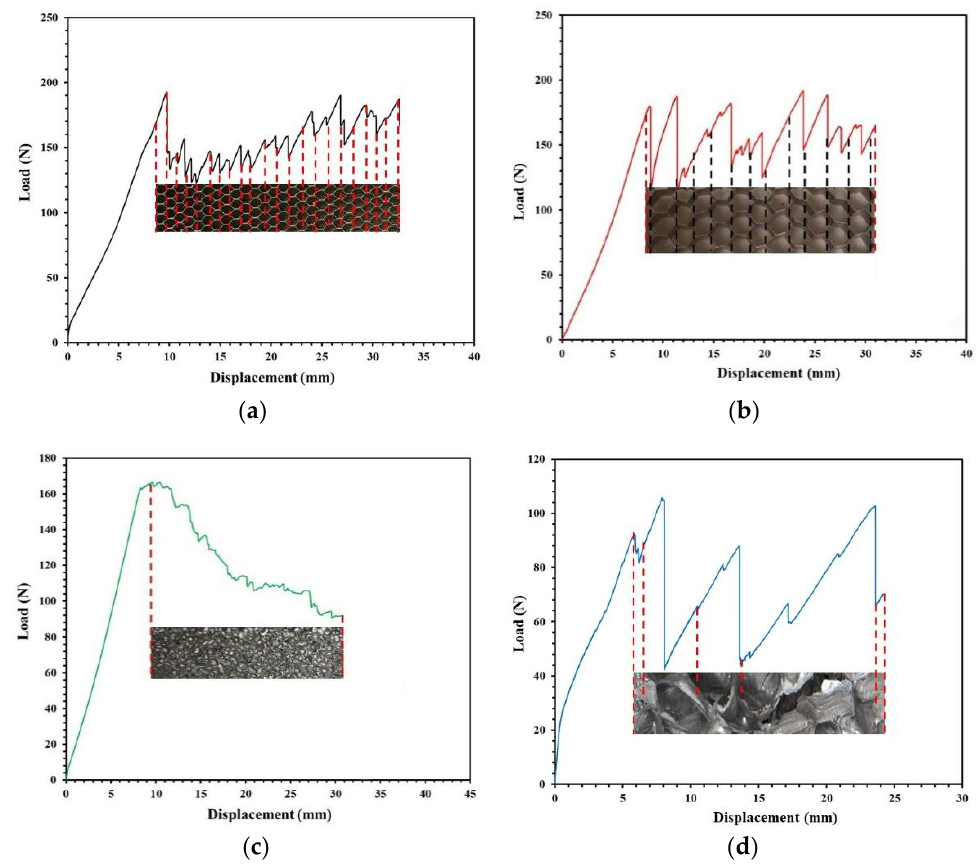
Figure 12. Comparison of core surface geometry to the load vs. displacement plot ( a ) HDHC; ( b ) LDHC; ( c ) HDFC; ( d ) LDFC.